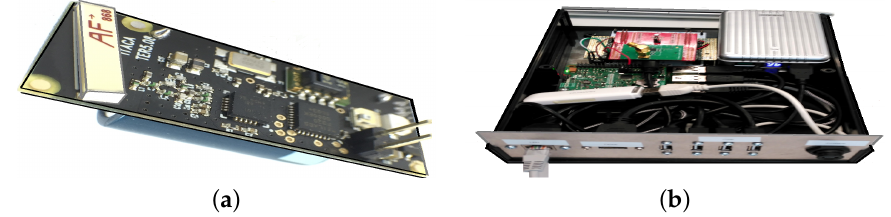
1.5 1.5 cm); ( b ) sink × ×